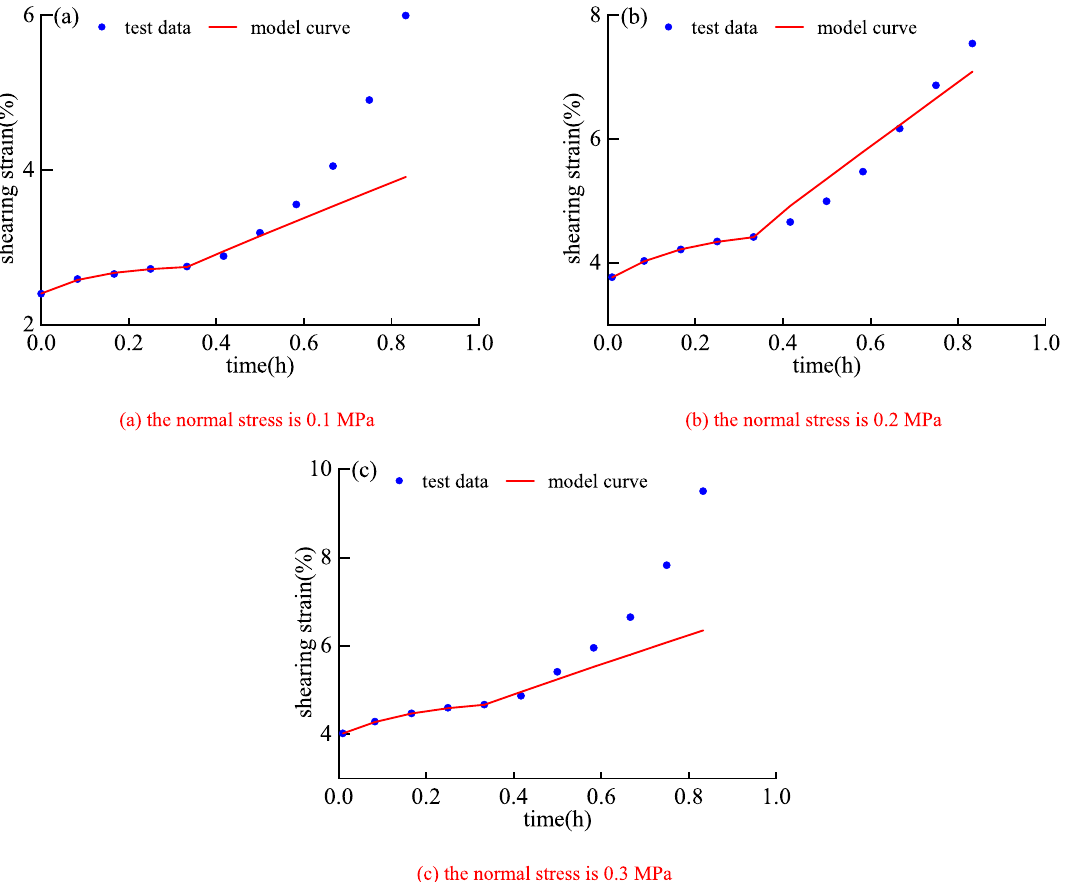
Figure 9. Comparative analysis between the Nishihara model curve and the test